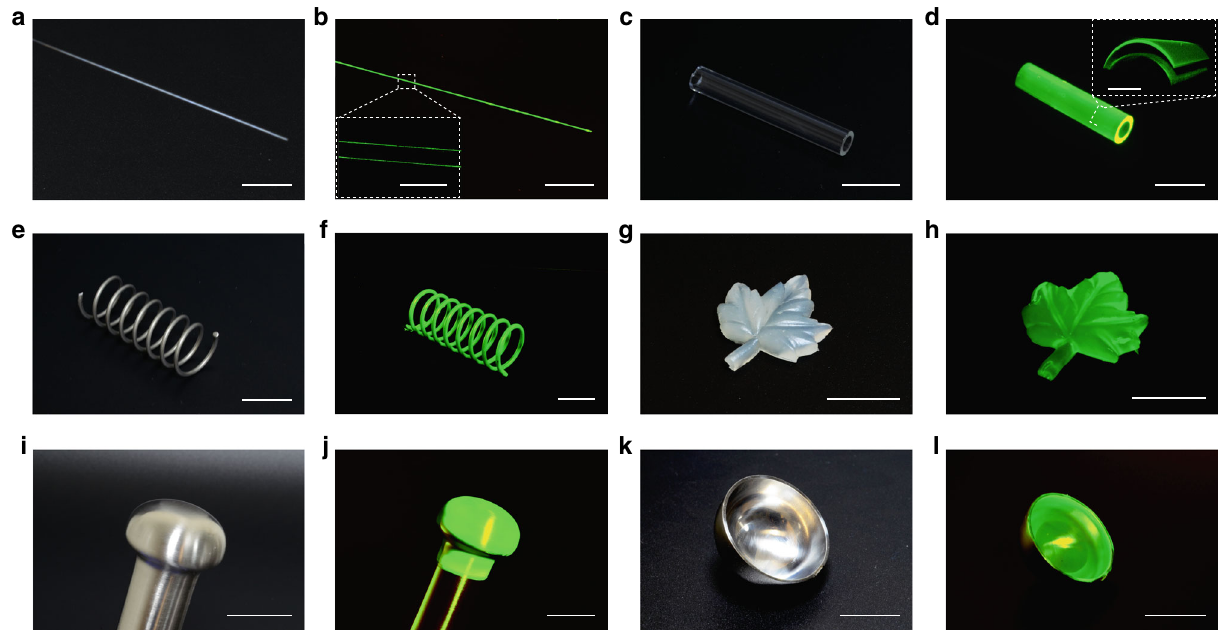
Fig. 5 Fatigue-resistant hydrogel coatings on various materials with complex geometries. a , b A glass optical fi ber (200 μ m in diameter) with ( b ) and without ( a ) fatigue-resistant hydrogel coatings. Inset in b confocal laser-scanning microscopic (CLSM) image of the hydrogel coating ( ∽ 20 μ m in thickness) on the glass optical fi ber. c , d A glass tube with ( d ) and without ( c ) fatigue-resistant hydrogel coatings on the inner and outer surfaces. Inset in d 3D CLSM image of the hydrogel coating on both inner and outer surfaces. e , f A stainless steel spring with ( f ) and without ( e ) fatigue-resistant hydrogel coatings. g , h A leaf-shaped elastomer with ( h ) and without ( g ) fatigue-resistant hydrogel coatings. i , j A convex end of the ball-and-socket metallic joint with ( j ) and without ( i ) fatigue-resistant hydrogel. k , l A concave end of the ball-and-socket metallic joint with ( l ) and without ( k ) fatigue-resistant hydrogel coatings. The hydrogel coatings are colorized with fl uorescein sodium salt dye for visualization and all the images of b , d , f , h , j , l are taken under a blue light excitation (480 nm in wavelength). Scar bars: 20 mm in ( a – l ), 500 μ m in the inset of ( b ), and 2 mm in the inset of ( d